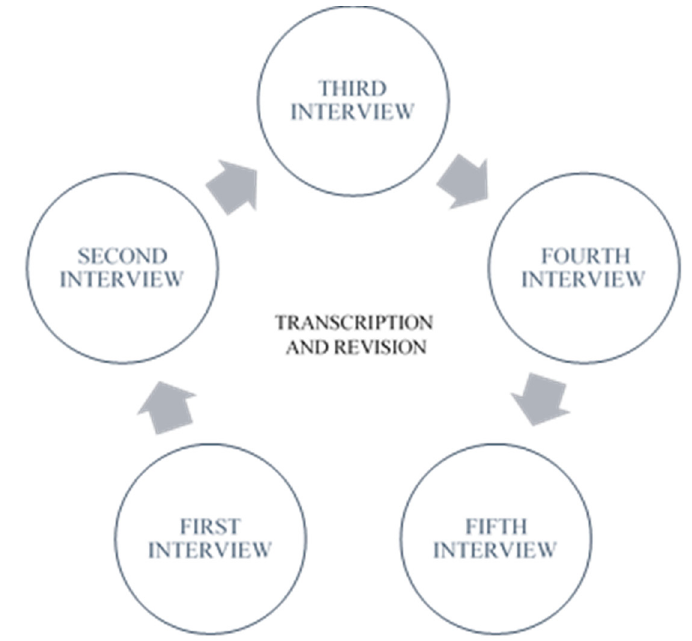
Figure 1. Cyclical method of data collection and analysis.